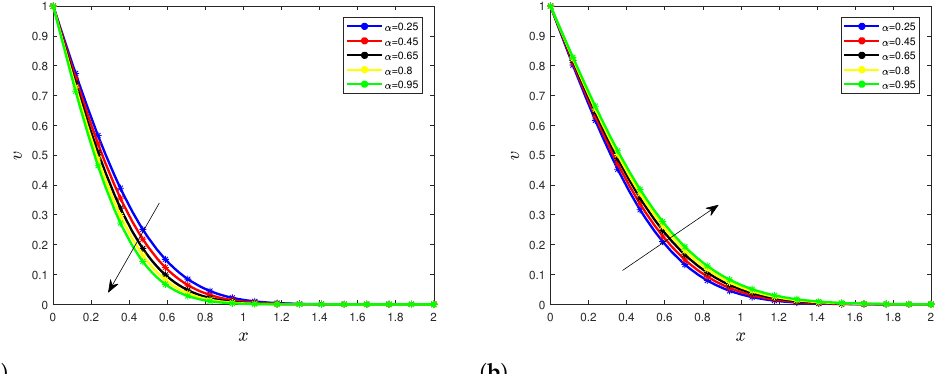
Figure 2. Dynamics of the fractional heat equation with various order with, respectively, τ = 0.5 ( a ) and τ = 1.5 ( b ) for Pr =